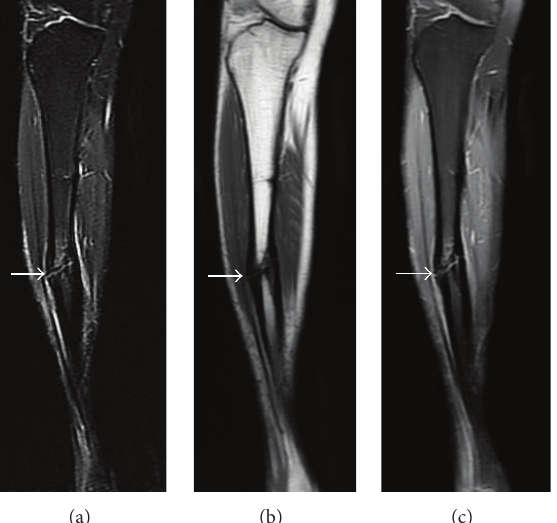
Figure 8: Young adult male with history of Rothmund-Thomson syndrome diagnosed at 2 years of age. Findings: (a) recurrent mildly displaced right tibia diaphyseal fracture (arrow) with mild associated bone marrow edema and adjacent soft tissue edema. (b) Cortical thickening is present at the fracture site (arrow). There is no mass-like bone lesion identified, and normal fatty marrow signal extends almost to the fracture line. (c) Mild bone marrow and periosteal enhancement is present at the fracture site (arrow). No nodular or mass-like enhancement is present. Technique: (a) coronal STIR MRI (TR = 6350, TE = 44.5), ST = 5mm, spacing = 6mm, FOV = 38.0 × 44.8 cm, and matrix = 224 × 320; (b) coronal T1 MRI (TR = 650, TE = 13.2), ST = 5 mm, spacing= 6mm, FOV = 38.0 × 44.8 cm, and matrix = 224 × 352; (c) coronal T1 postcontrast fat-saturated MRI (TR = 650, TE = 12.3), ST = 5mm, spacing = 6 mm, FOV = 38.0 × 44.8 cm, matrix 224 × 320, and contrast = 13mL,